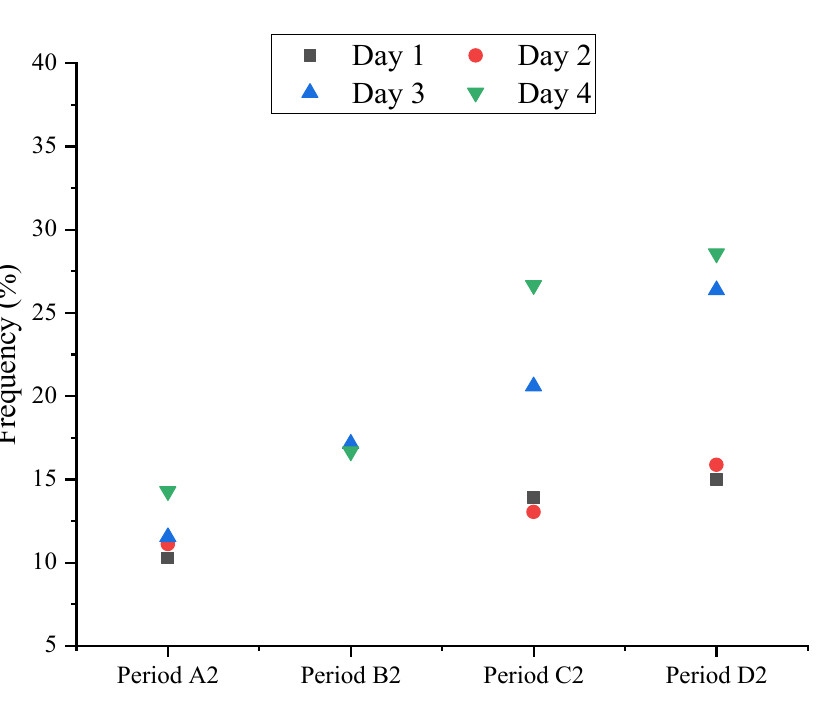
Figure 13. Clothing insulation value in different periods.